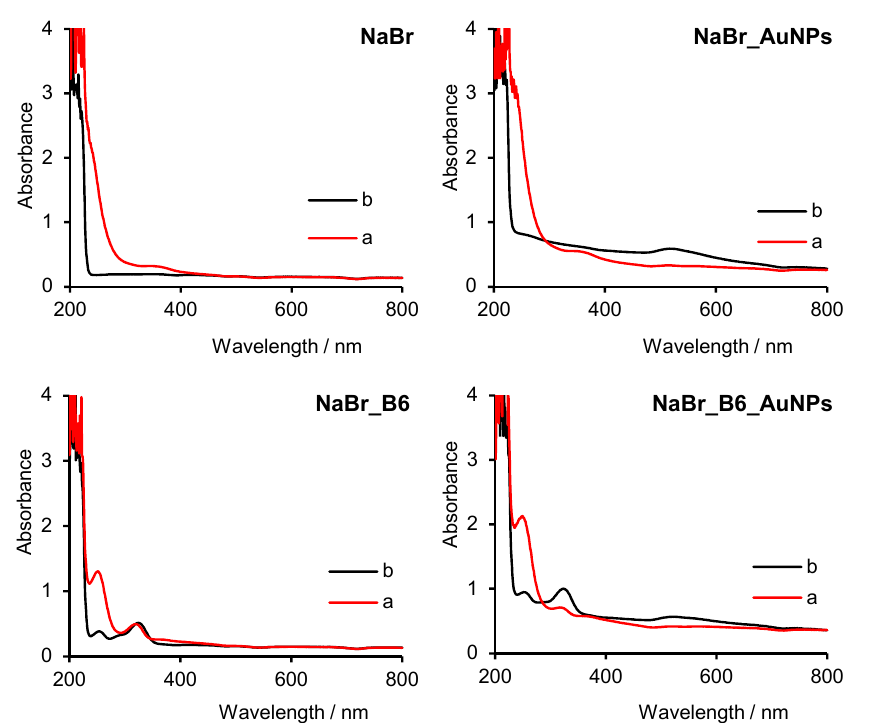
Figure 9. UV–Vis absorption spectra of electrolyte solution containing NaBr/B 6 /AuNP systems; b—before and a—after performing cyclic voltammetry.